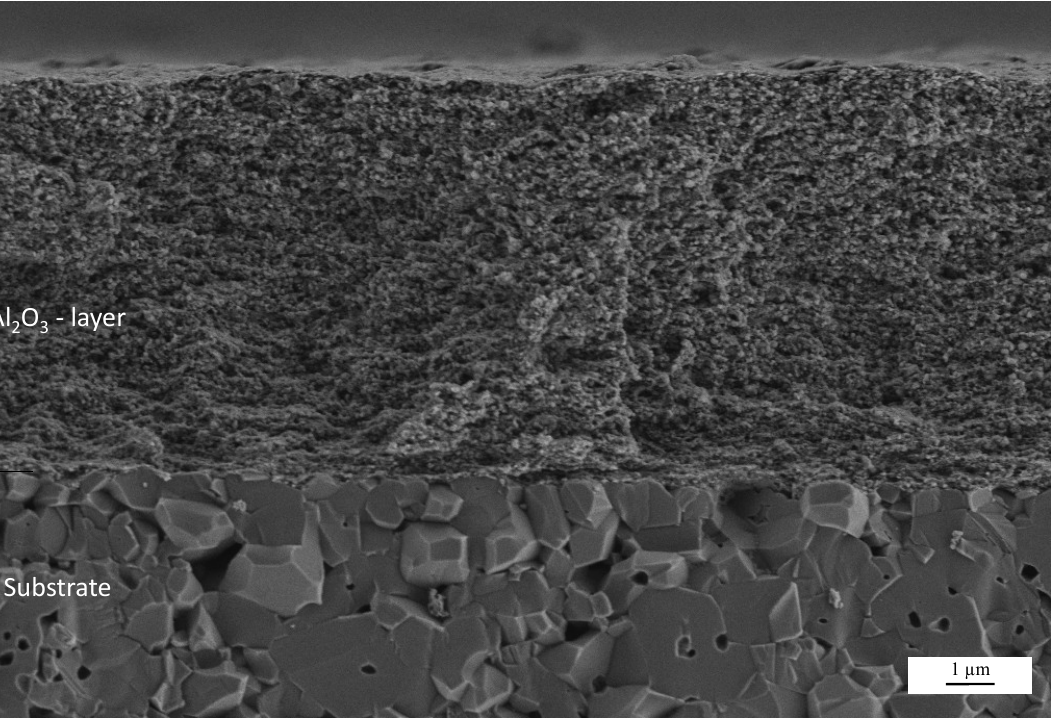
Figure 3. SEM cross-sectional fracture pattern of an Al alumina substrate. Deposition parameters: 100% N